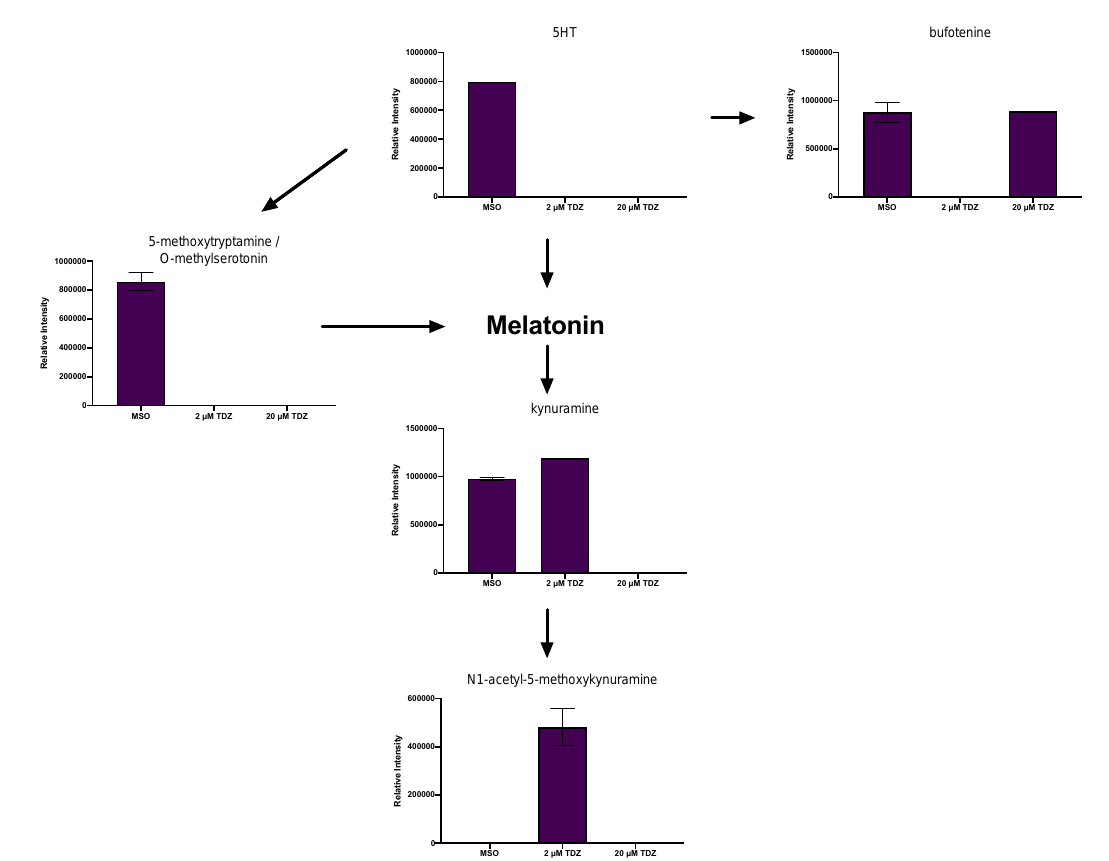
Figure 6. Effects of thidiazuron (TDZ) exposure on indoleamine biosynthesis and metabolism in African violet petioles. Bars represent mean, error bars span standard error margin. Where no error bars are displayed, the feature was present in only one replicate. Arrows indicate the normal flow of the pathways.